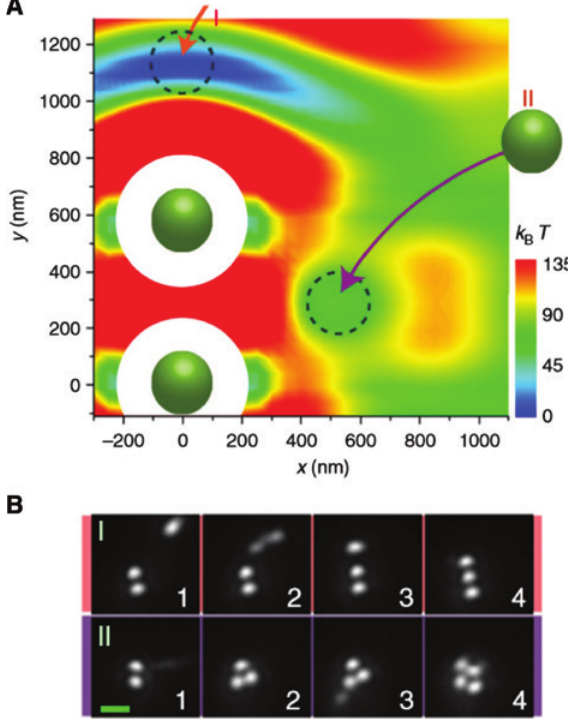
Figure 6: Path-dependent self-organisation of three 200 nm diameter Ag nanoparticles. (A) Potential energy surface of a third Ag particle joining an optically bound dimer in an optical field with 800 nm wavelength, and pathways of the third particle. (B) Corresponding images of two experimental events in which the third particle enters the optical field from different directions. Images II-3 and II-4 show the addition of a fourth nanoparticle. The relative time points of the images in I are 0 s, 0.01 s, 0.02 s, and 1.82 s while those in II are 0 s, 0.01 s, 0.66 s and 0.67 s, respectively. Scale bar, 1 μ m. Reproduced with permission from